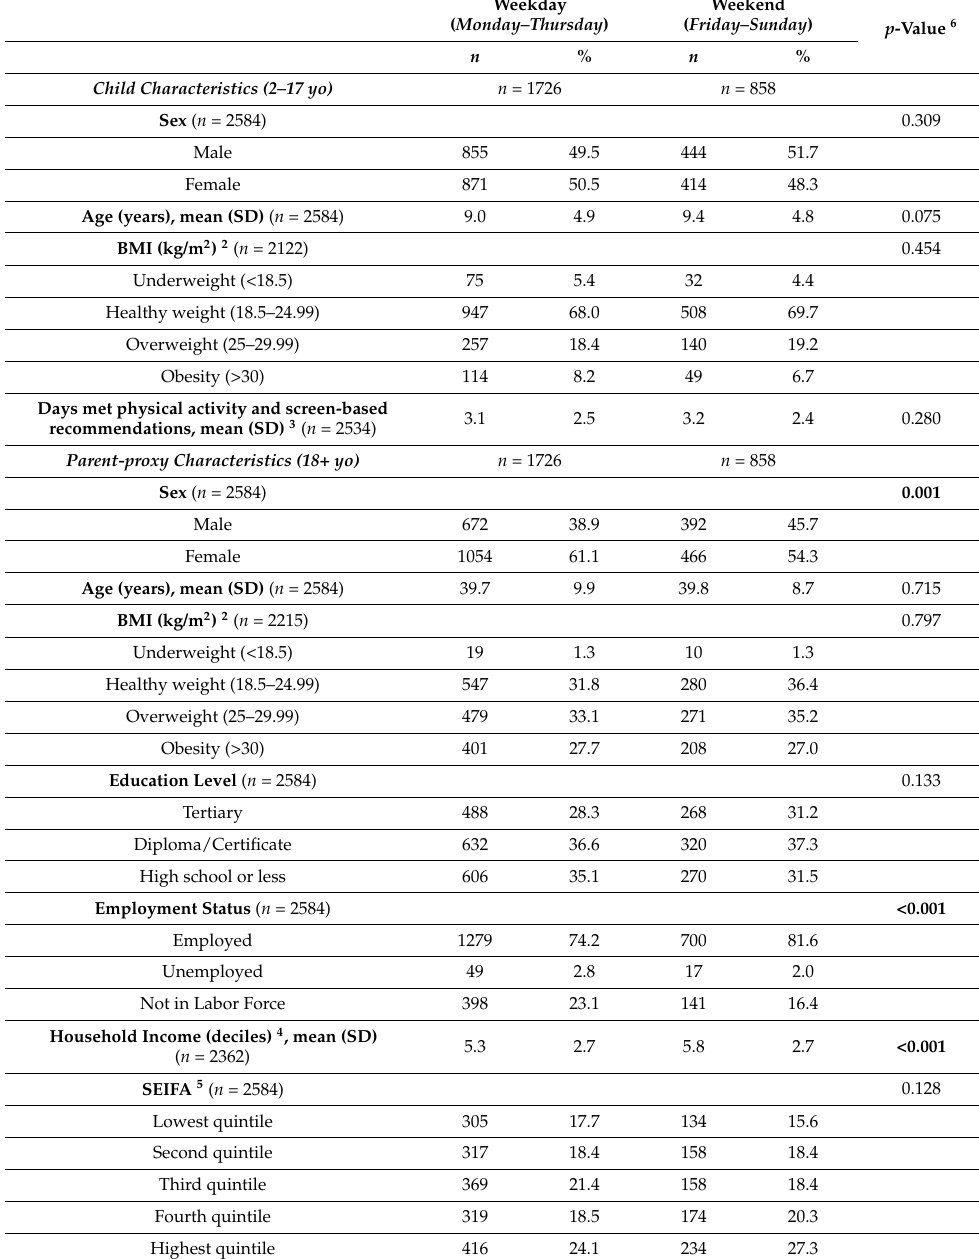
Table 1. Characteristics of weekday and weekend samples of children and adolescents and parent- proxy from the National Nutrition and Physical Activity Survey 2011–2012 1